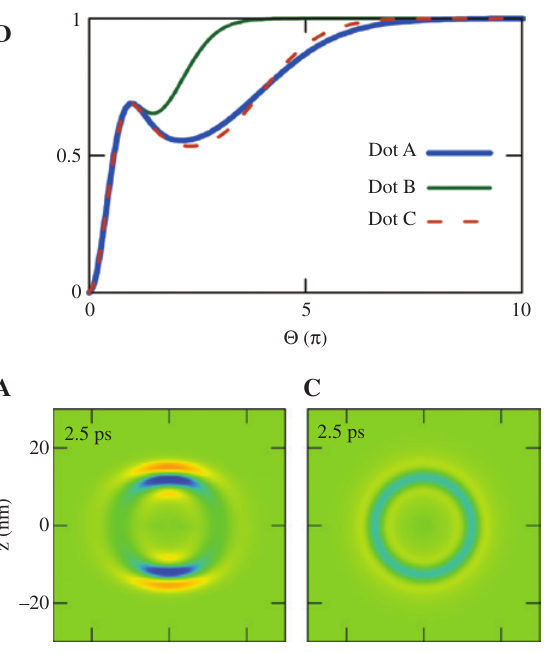
Figure 5: (D) Final occupation of the excited QD state for a strongly lens-shaped QD (A) and two spherical shaped QDs (B, C). Despite different geometries QD, A and C show quantitative and qualitative the same dependence on the pulse area. (A) and (C) The relative volume change after an excitation with a 2 π pulse for (A) a lens- shaped and (C) a spherical shaped QD. The outgoing phonon waves differ strongly in directionality. Reprinted figure with permission from [96]. © 2017 by the American Physical